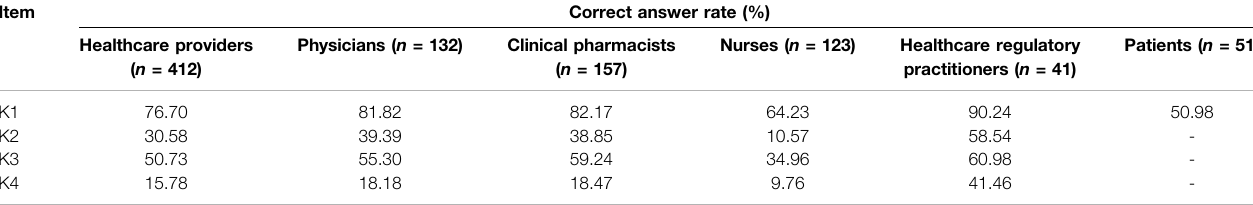
TABLE 2 | Results of Knowledge among different